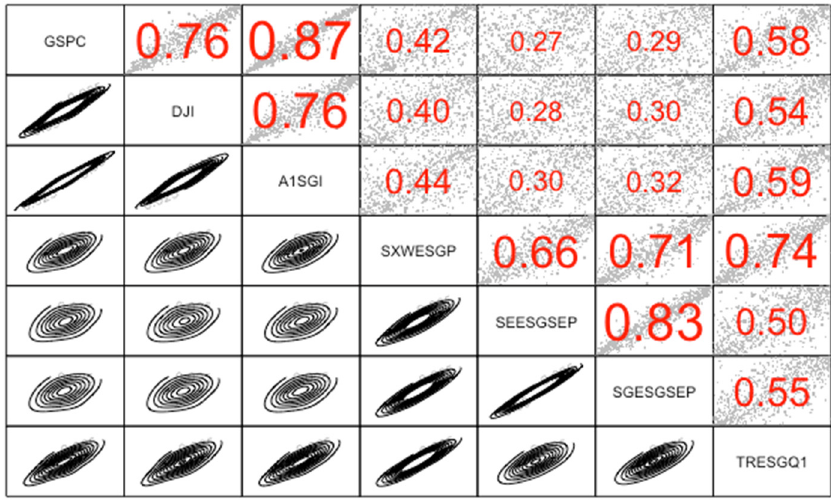
Figure 8. Kendall’s τ and copulas, 4 January 2017–31 December 2019.